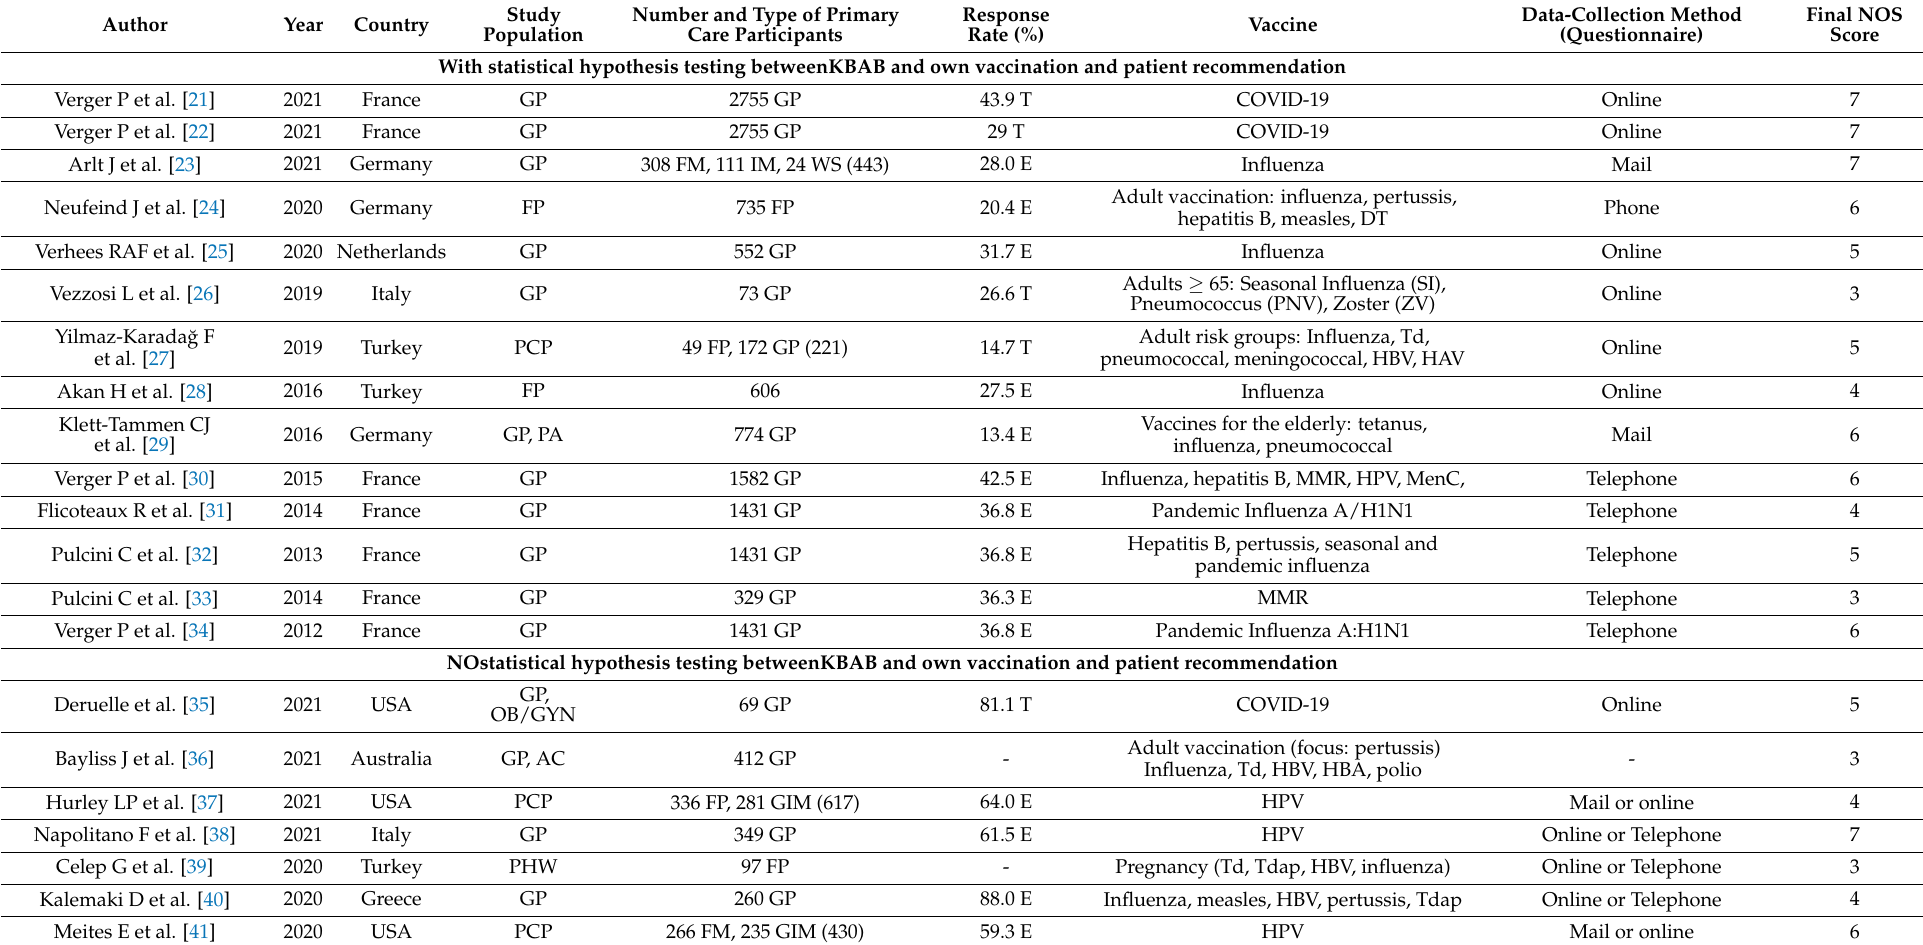
Table 1. Methodological characteristics of the papers